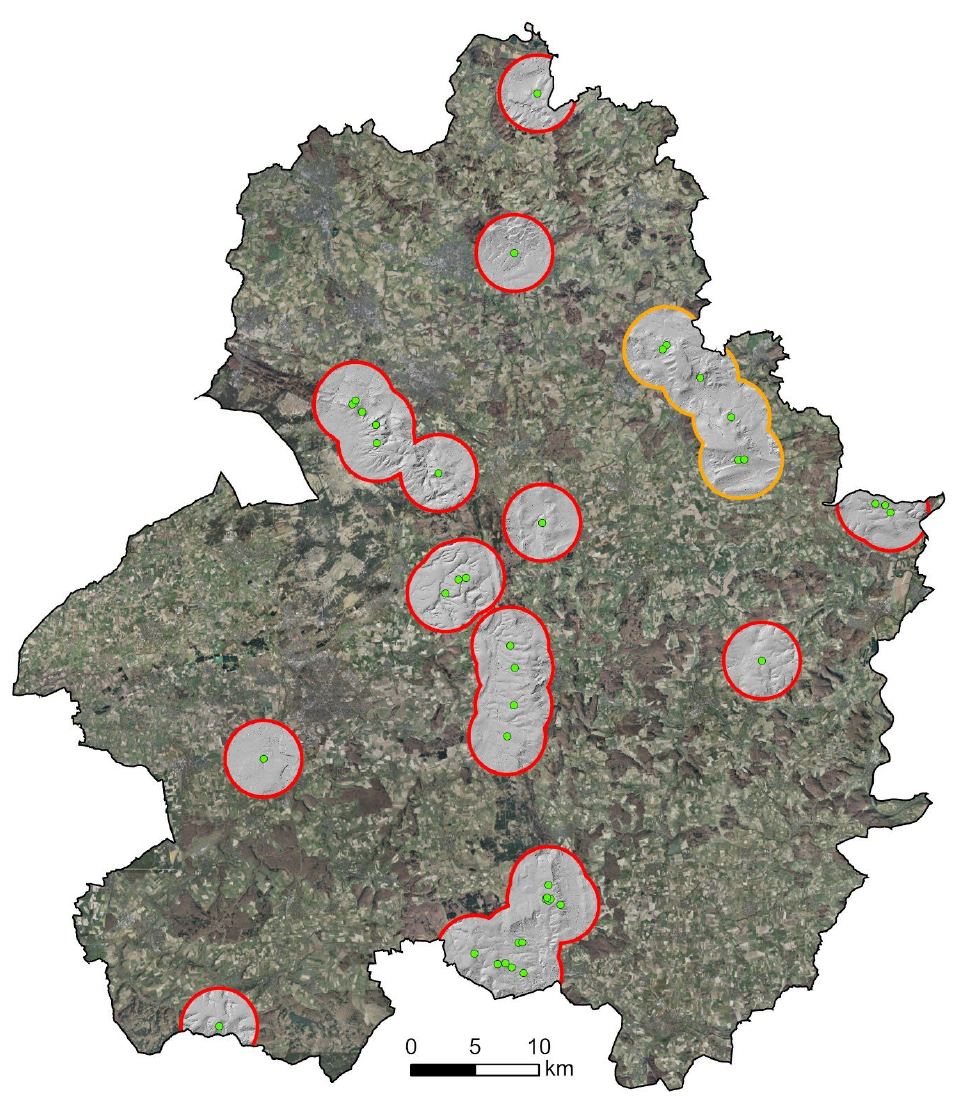
Figure 4. Overview of the hollow ways (green) including 3 km buffer zones (red and orange), for which the DTM was acquired (grey). The orange area is a subset, in which the CNN was tested before application on the whole dataset (red). Data source: [25].